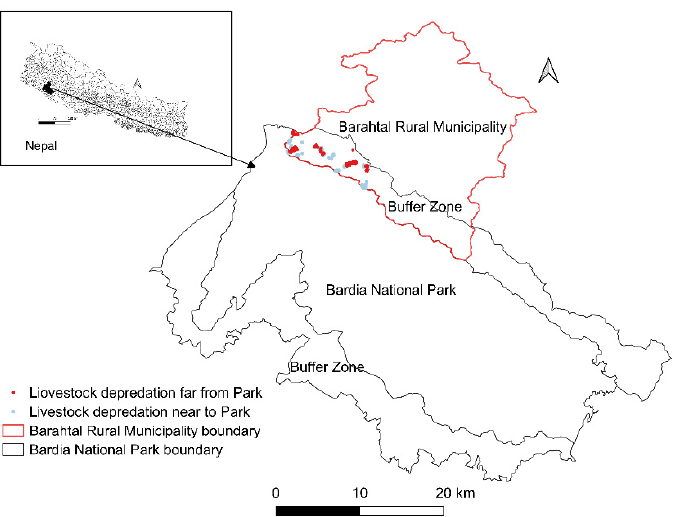
Figure 1. Study area with locations of reported livestock depredations near Bardia National Park, Park, Nepal.